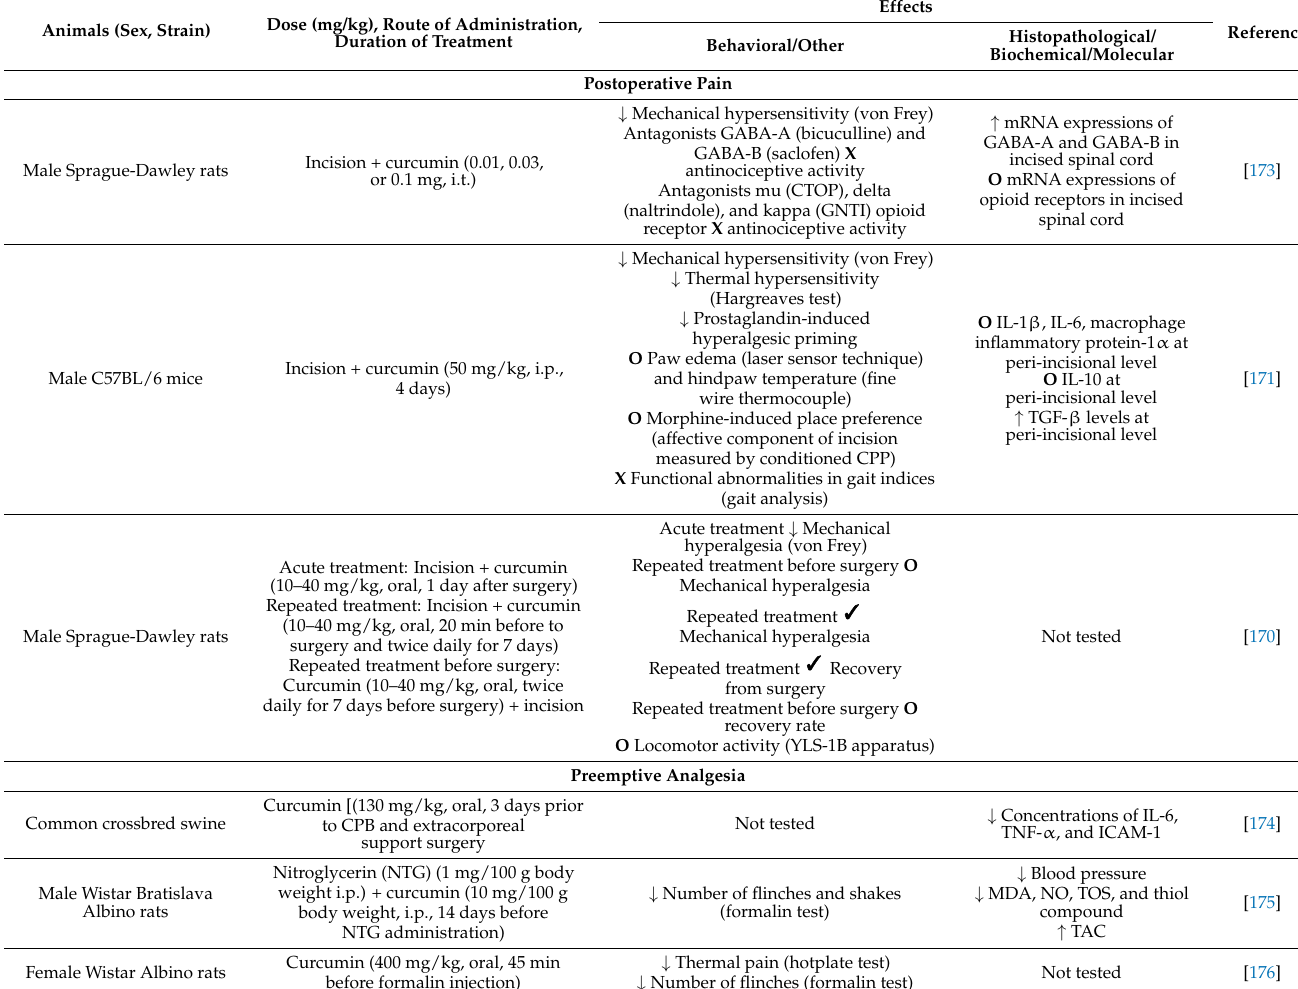
Table 5. Effects of curcumin on postoperative and preemptive analgesia. Animals (Sex, Strain)